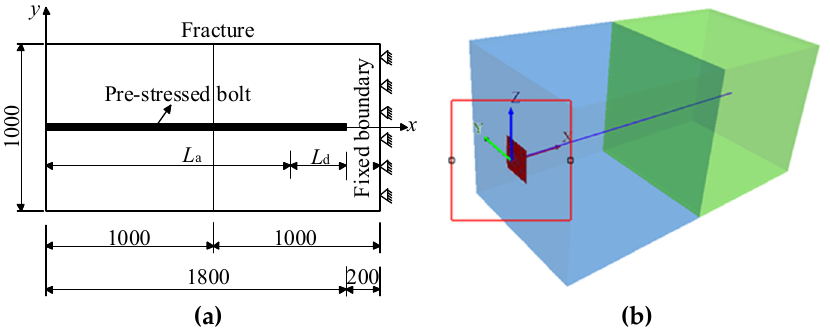
Figure 4. Numerical model. ( a ) Model parameter; ( b ) 3D model.